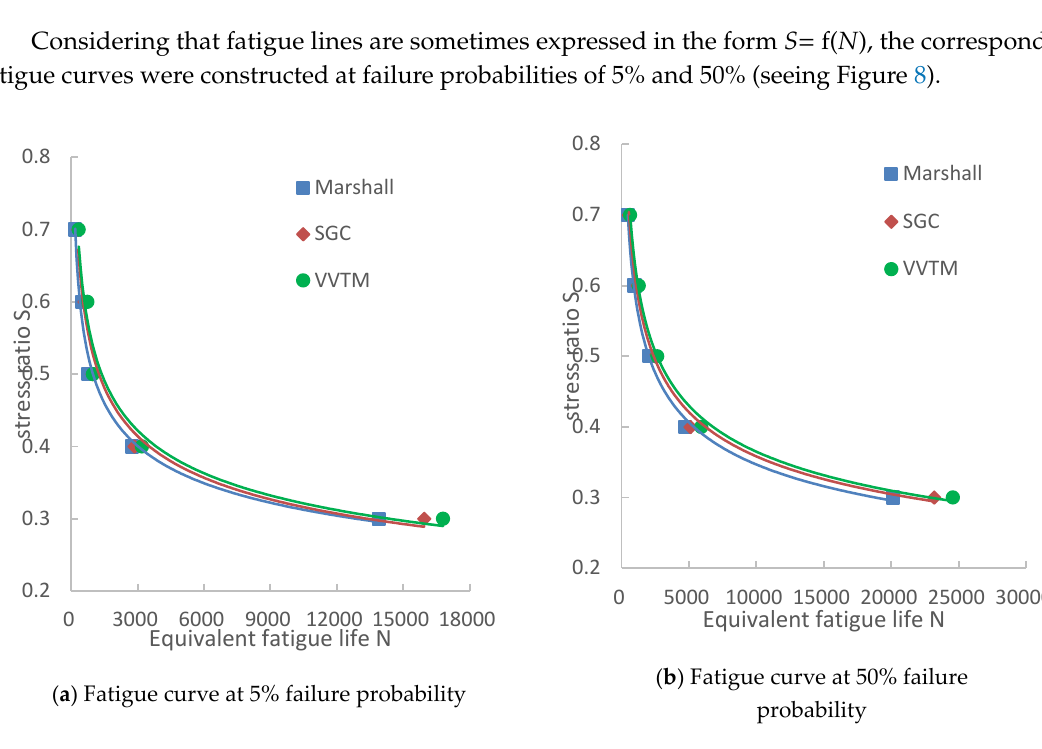
Figure 8. Fatigue curves of the SMA-13 asphalt mixtures designed by the three methods.